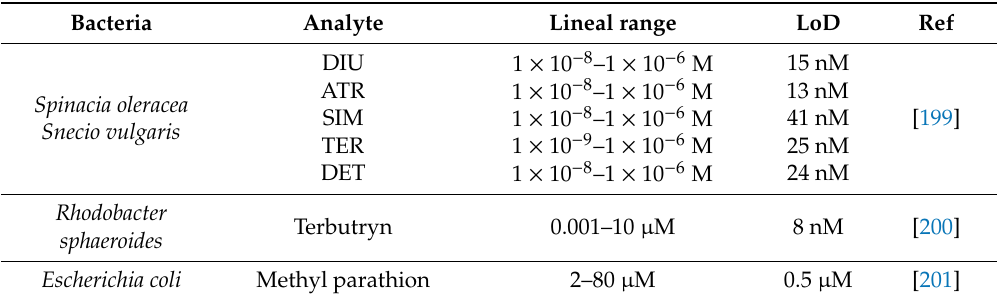
Table 6. Biological sensors reported for pesticides determination on screen-printed electrodes.